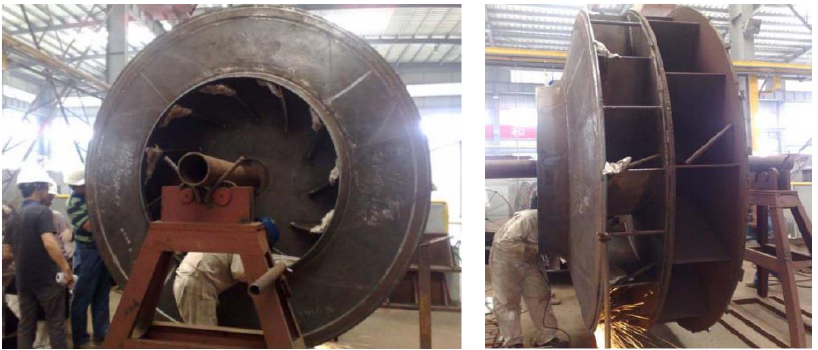
Figure 3. Photos of the rotor blades of No. A fan.